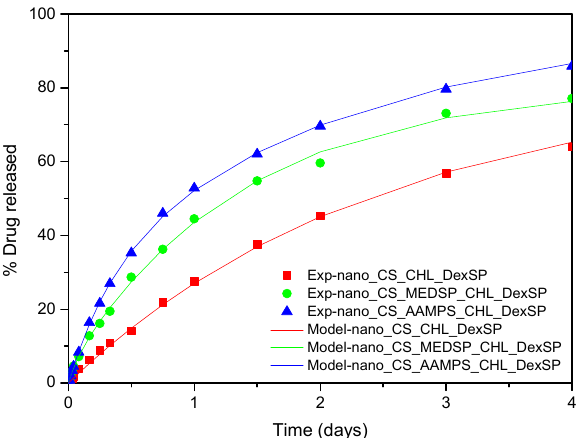
Figure 12. Comparison between model (solid lines) and experimental (symbols) release curves for DexSP in three types of nanoparticles.